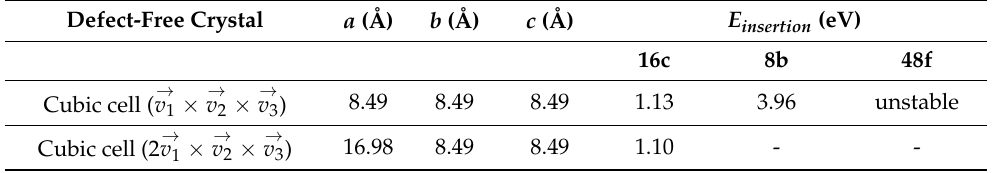
Table 1. Structural properties of magnetite ( insertion energies for interstitial sites, from PBE+U Density Functional Theory